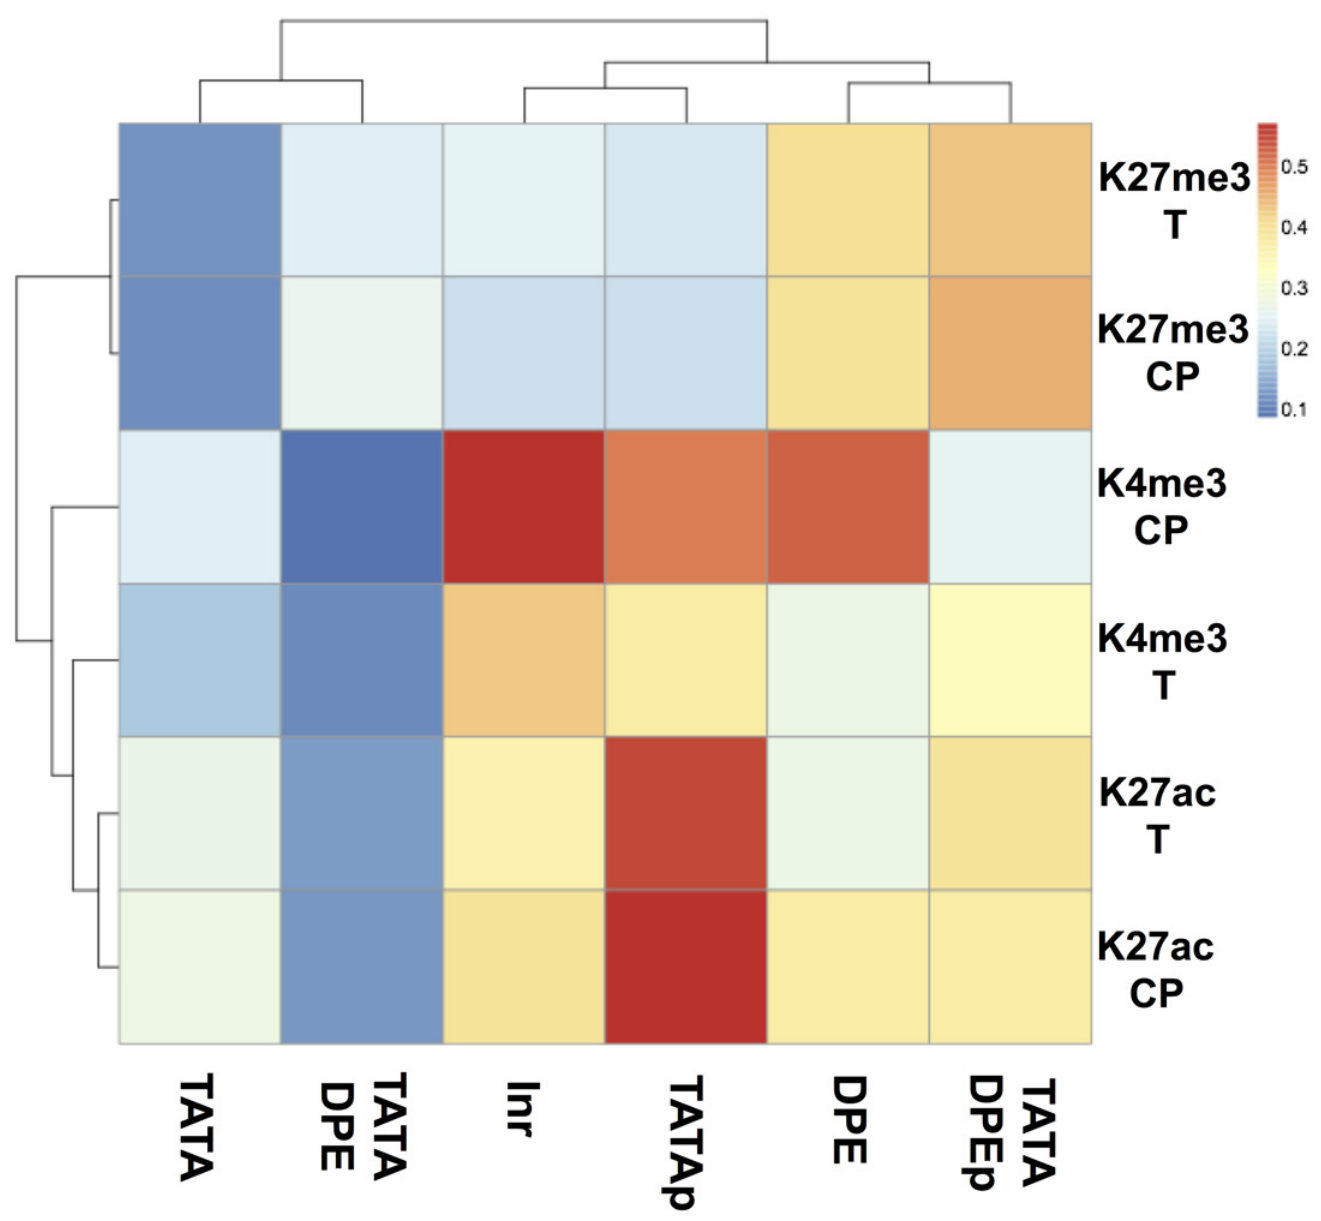
Fig 5. Heatmap of the relative histone modification frequency. The frequency was obtained by calculating the ratio of core promoters whose histone modification ratio was more than 0.5. The y-axis represents the histone modifications, and the x-axis represents the CPE groups. The orders in the y- and x- axes reflect the results of hierarchical clustering using the pheatmap package in R. The warm color represents the high ratio of core promoters whose histone modification ratio is more than